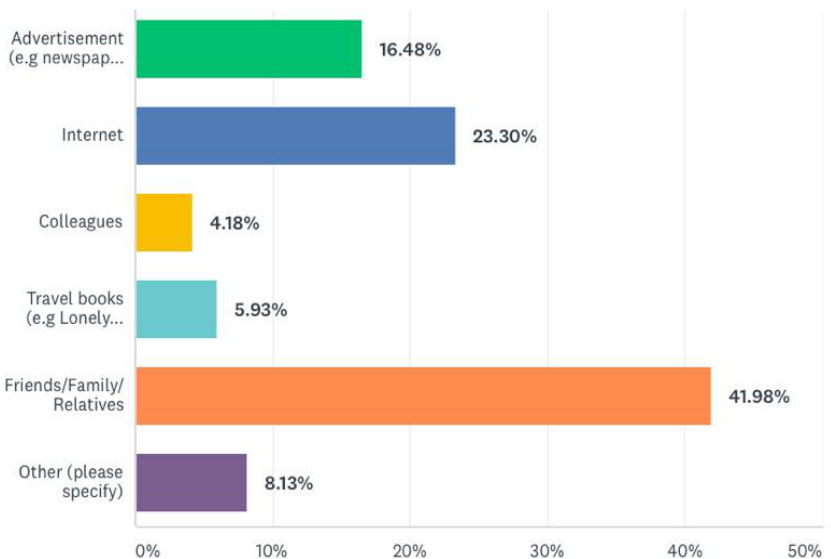
Figure 2. Channels of destination information. Note: responses to the question “Where did you hear about Hawai’i as a vacation destination?”.